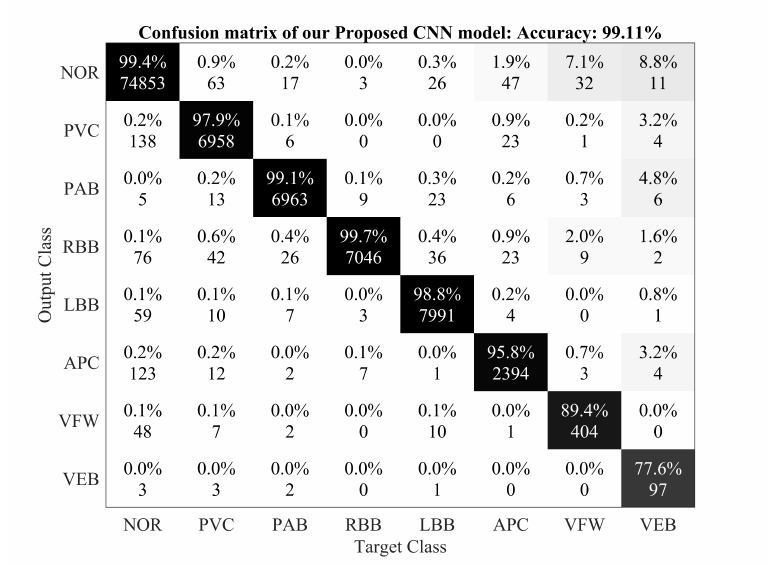
Figure 5. Confusion matrix for the proposed 2-D CNN based classification